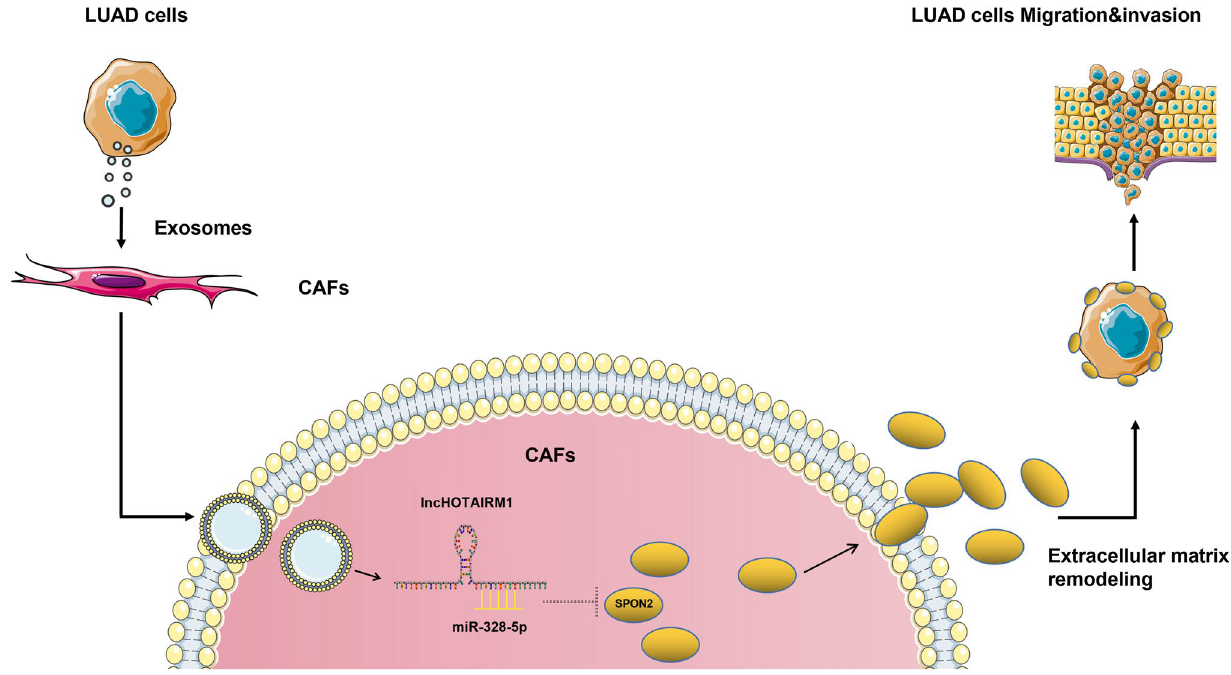
Fig. 5 Schematic representation of a deduced regulatory network in which HOTAIRM1 regulates SPON2 through competitive adsorption of